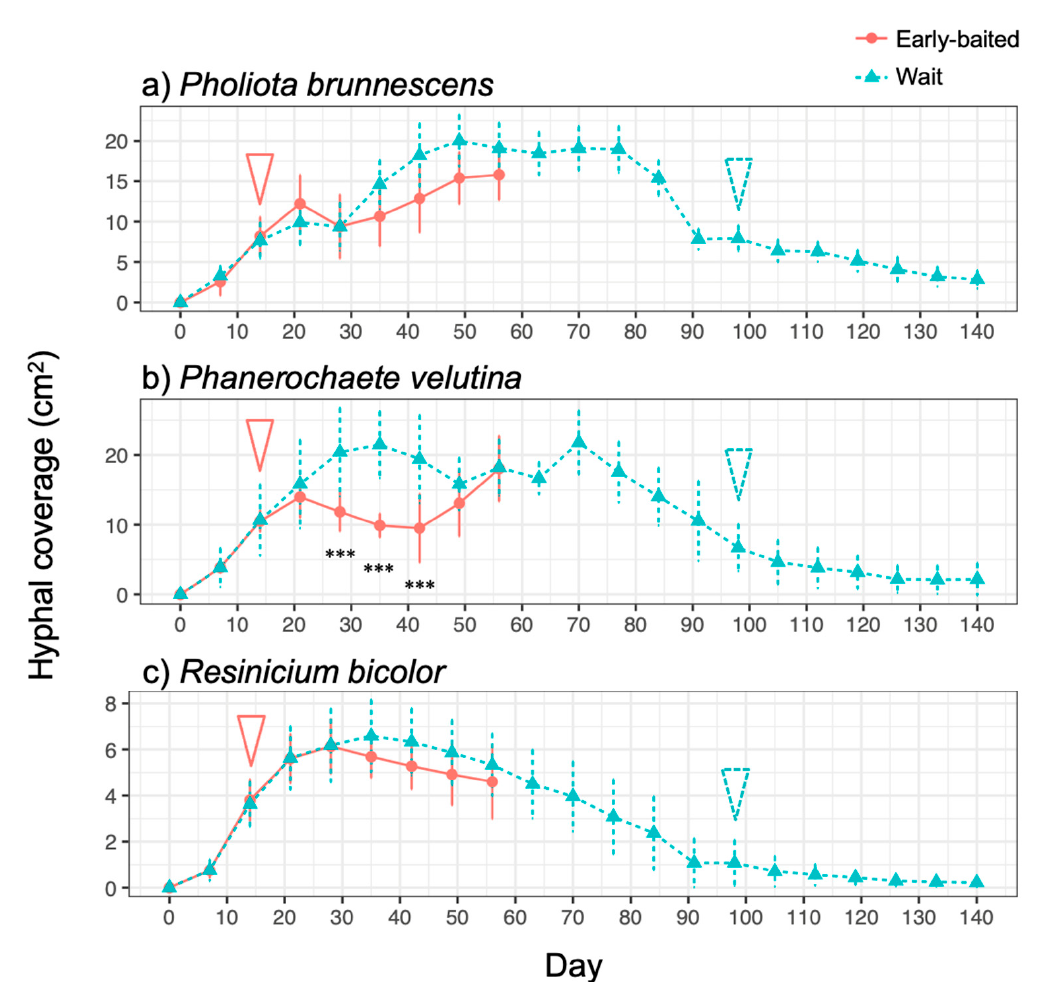
Figure 2. Change in hyphal coverage of ( a ) Pholiota brunnescens , ( b ) Phanerochaete velutina , and ( c ) Resinicium bicolor in response to added resources at different times. Pink round plots with solid line indicate the ‘early-baited’ experiment, while blue triangle plots with a dotted line indicate the ‘wait’ experiment. Pink solid arrow and blue dotted arrow indicate the time of addition of bait wood blocks to ‘early-baited’ and ‘wait’ experiments, respectively. Plots and error bars indicate mean and standard deviation, respectively ( N = 10). Asterisks indicate significant differences between ‘early-baited’ and ‘wait’ experiments: *** p < 0.001 (repeated measures ANOVA).